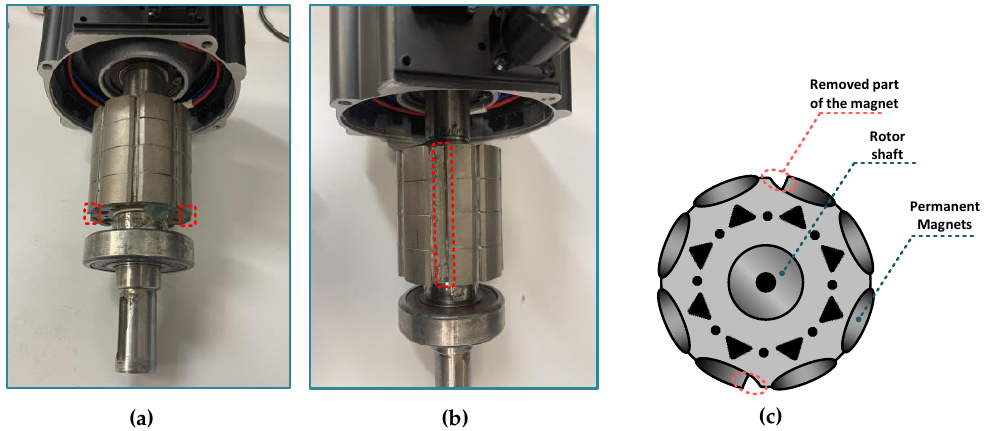
Figure 1. PMSM rotor with damaged PM: ( a ) construction of the tested PMSM rotor, ( b ) side view of the damaged rotor, ( c ) illustrative front of the rotor with implemented PM fault.